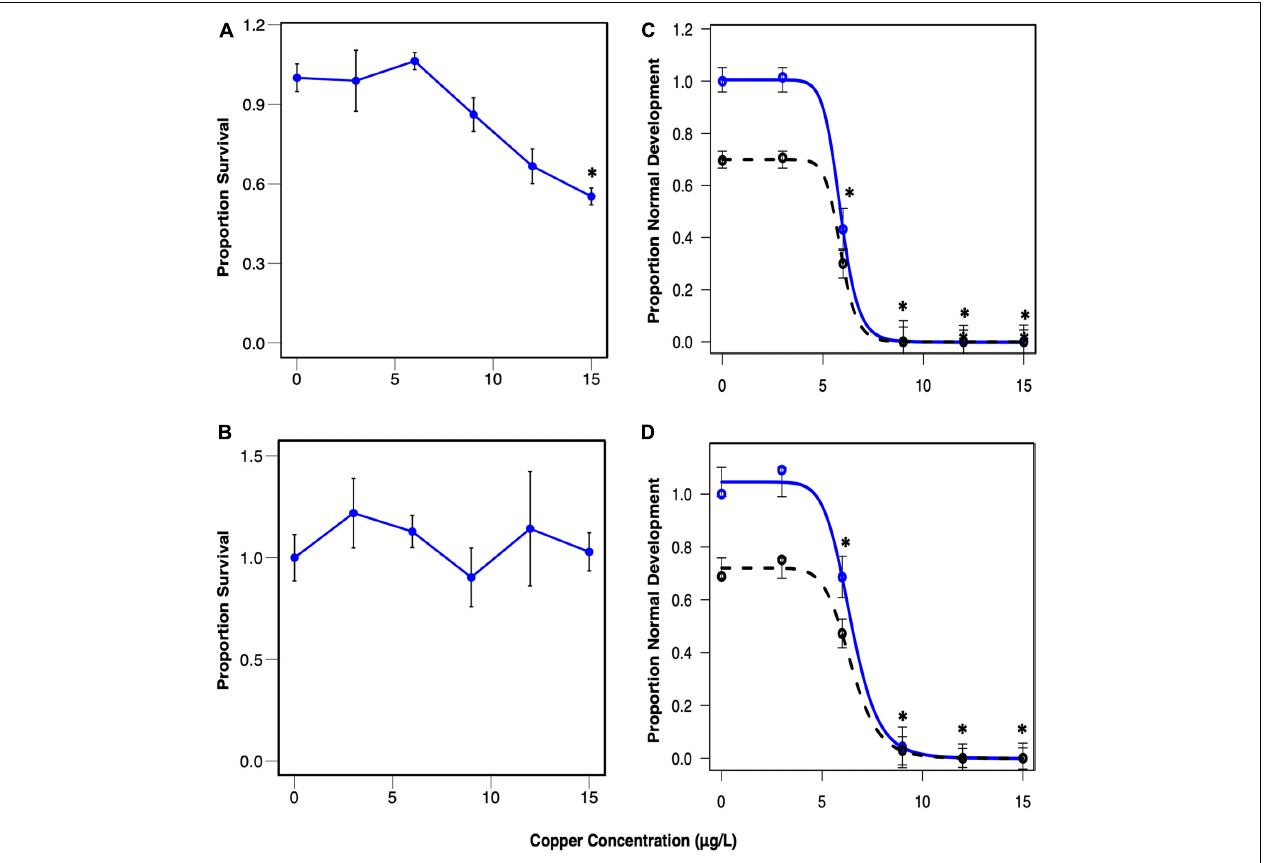
FIGURE 3 | Proportion of control-normalized survival in Trial 1 (A) and Trial 2 (B) and normal development in Trial 1 (C) and Trial 2 (D) plotted against copper concentration. Mean survival with standard error (A,B) and mean normal development with standard error and modeled 4-parameter log-logistic curves (C,D) are plotted. Blue points and lines represent control-normalized survival (A,B) and normal development (C,D) , while the black dashed line represents non-normalized normal development. Asterisks indicate concentrations that exhibited significantly different proportions from the control ( p < 0.005). The normal development EC50 was 5.87 µ g/L for the pooled larvae trial (Trial 1), and 6.43 µ g/L for the single larvae trial (Trial